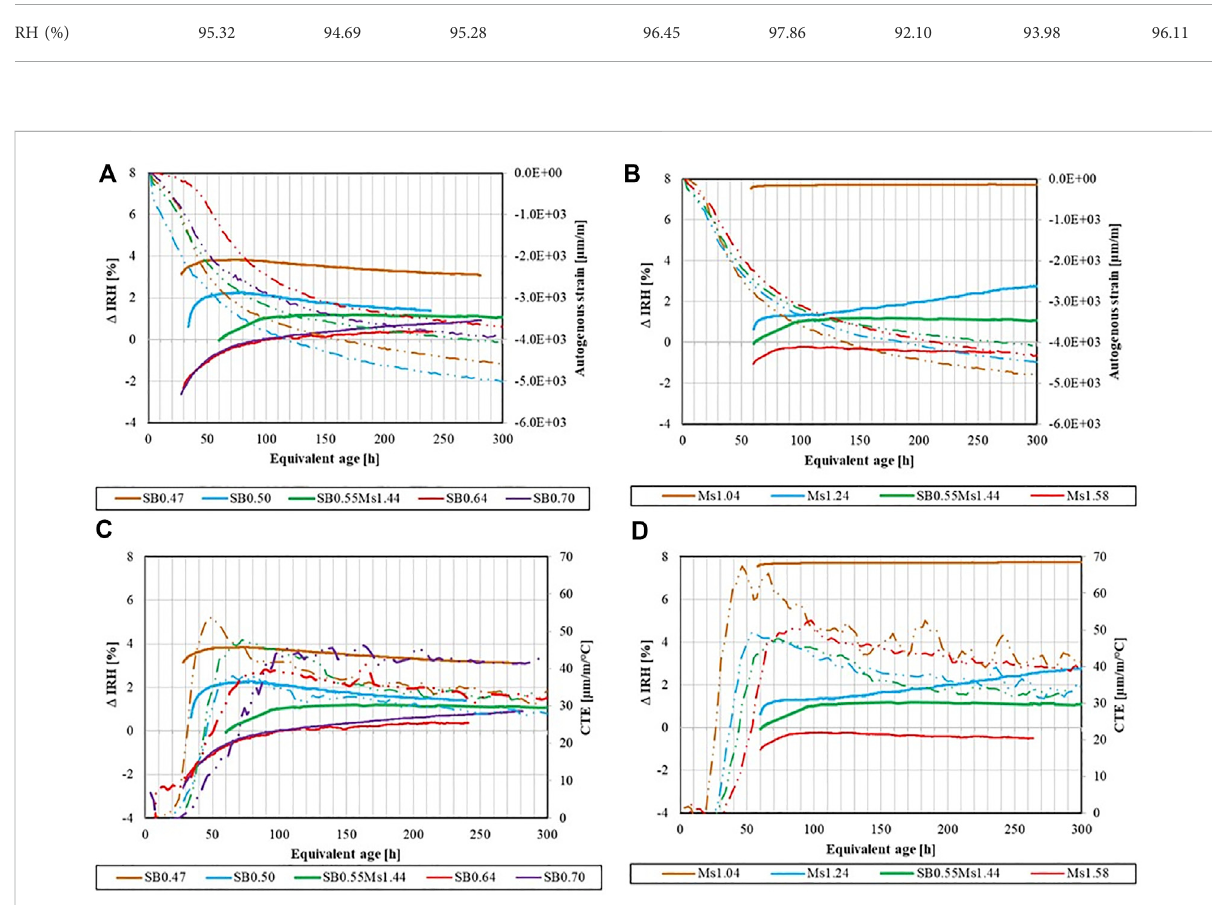
FIGURE 9 Comparison of IRH and autogenous strain with differentS/B (A) and with different M s (B) ; comparison of IRH and CTE with different S/B (C) and with different M s (D)